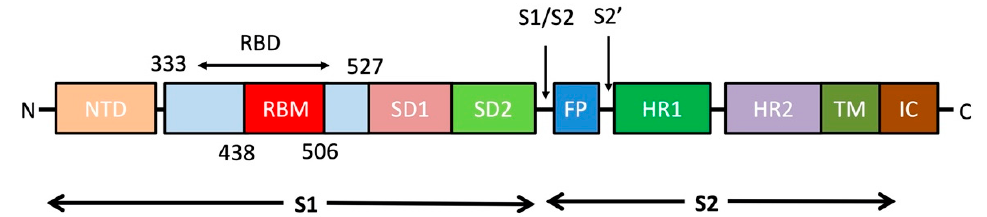
Figure 2. The overall topology of the SARS-CoV-2 S monomer. FP, fusion peptide; HR1, heptad repeat 1; HR2, heptad repeat 2; IC, intracellular domain; NTD, N-terminal domain; SD1, subdomain 1; SD2, subdomain 2; TM, transmembrane region [15].